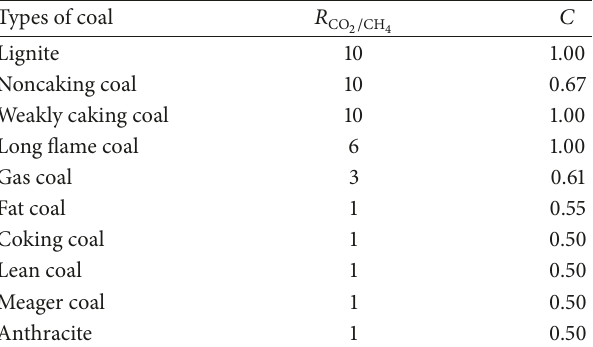
Table 3: The values of 𝑅 (USDOE, 2003). Types of coal 𝑅